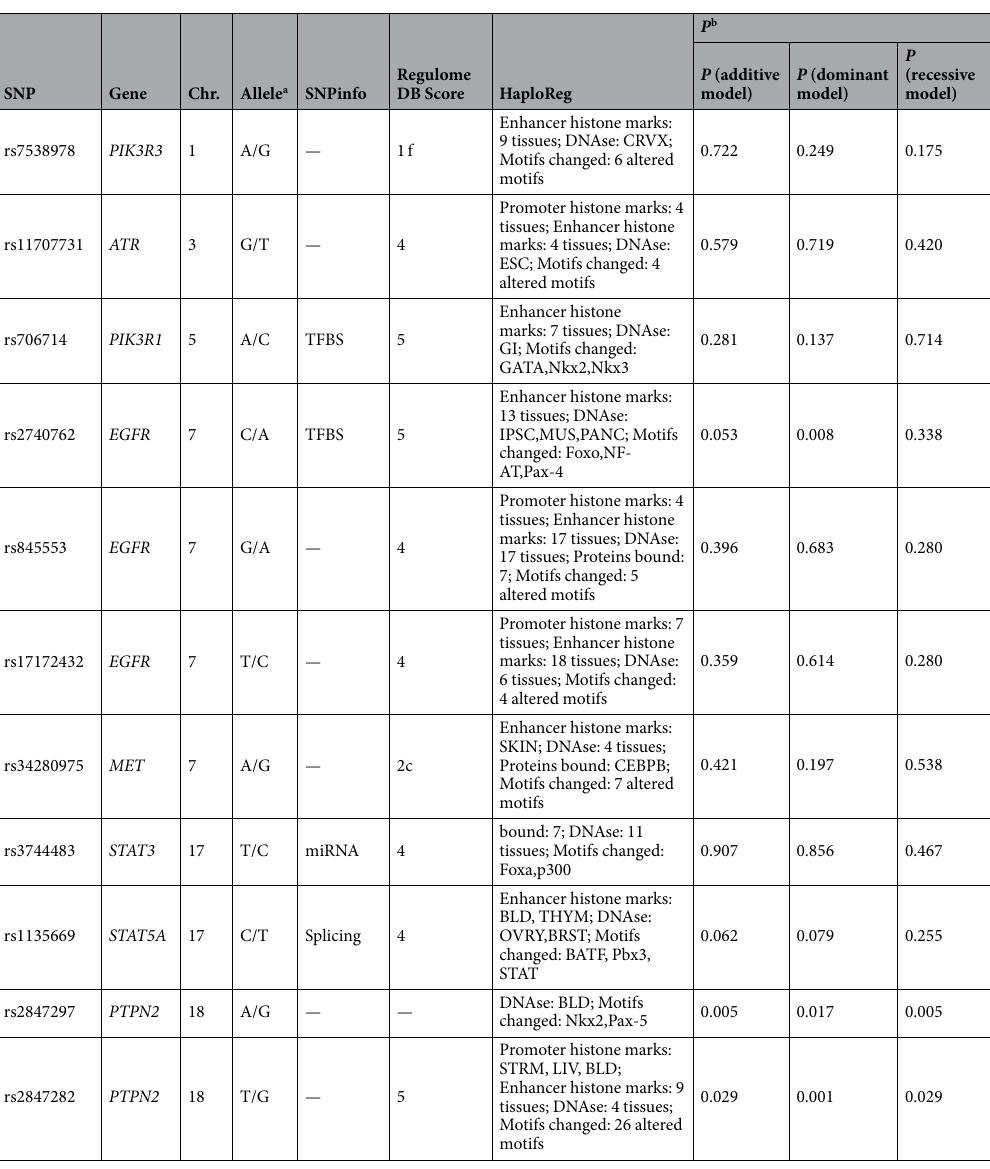
Table 1. Summary of the functional prediction and eQTL analysis results of the 11 selected SNPs in the TCPTP pathways in silico . a Reference allele/effect allele. b P value of eQTL analysis results TFBS = transcription factor binding